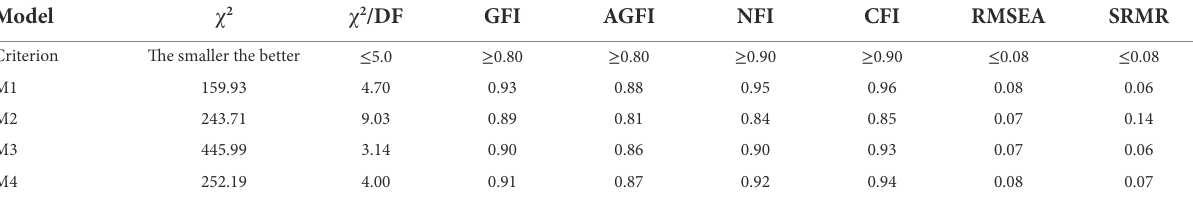
TABLE 4 Fit indexes of competition